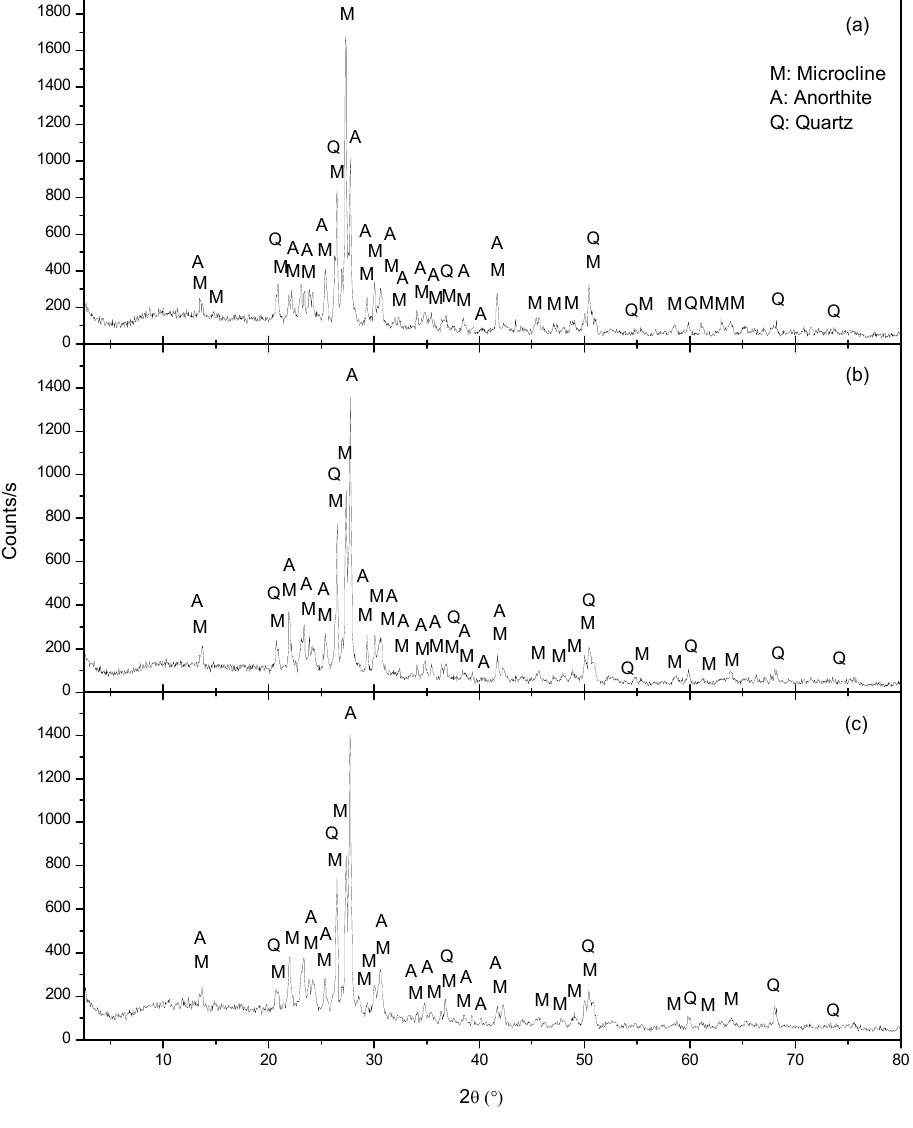
Figure 5. XRD patterns of the chlorination residue of the Mi sample at: ( a ) 700 °C, ( b ) 800 °C, ( c ) 900 °C and periods of 15 min.